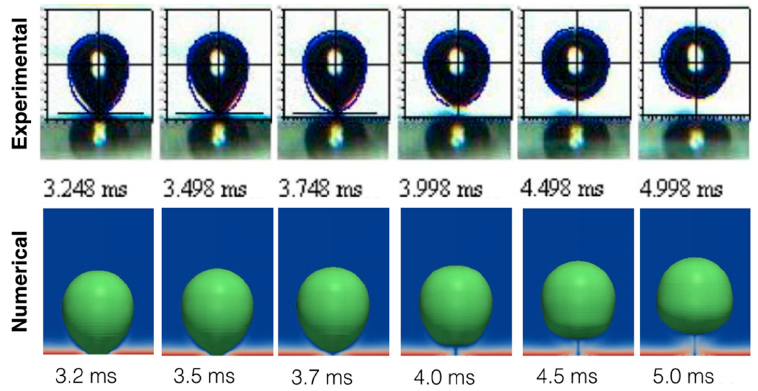
Figure 9. Qualitative comparison of experimental [38] and numerical (present investigation) 3D bubble